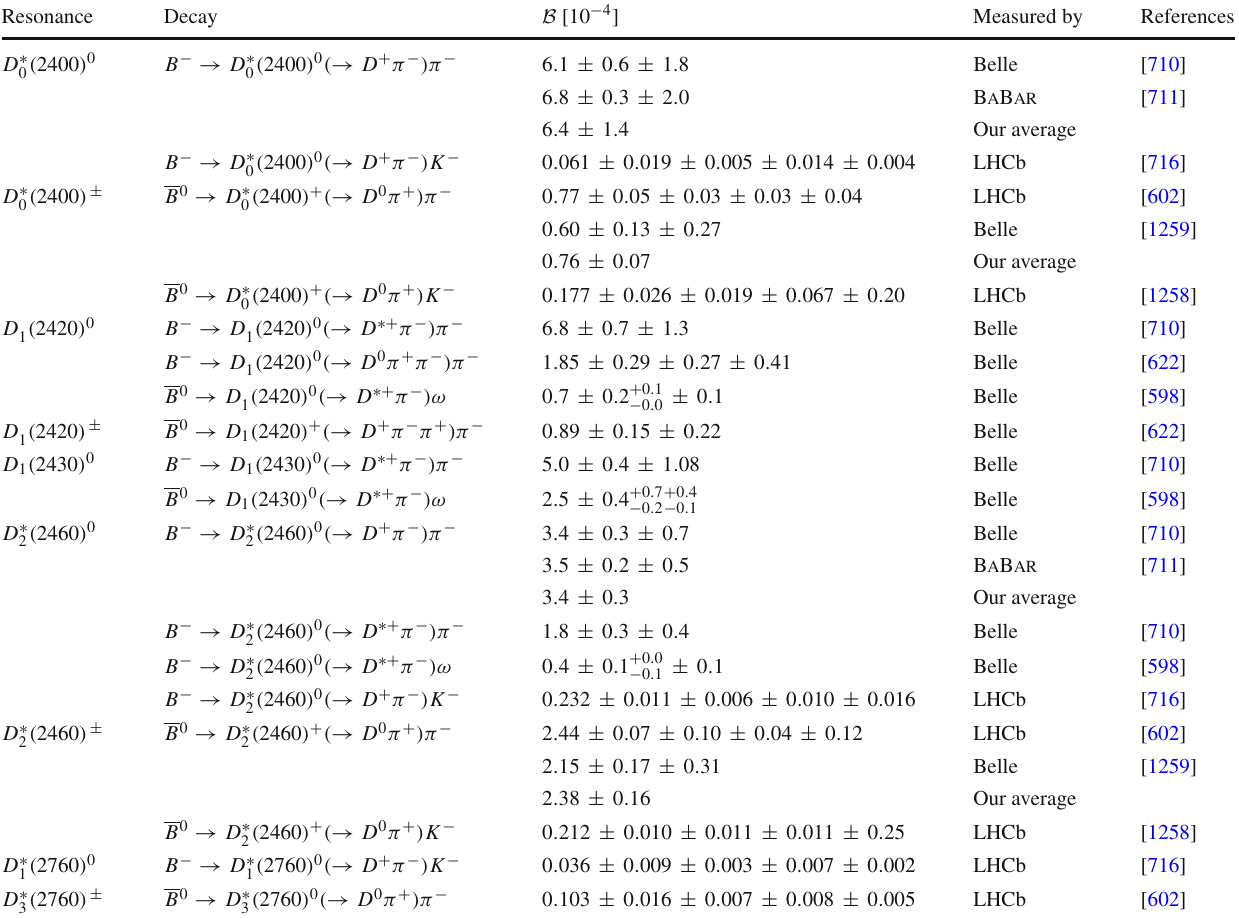
Table 292 Product of B meson branching fraction and (daughter) excited D meson branching fraction